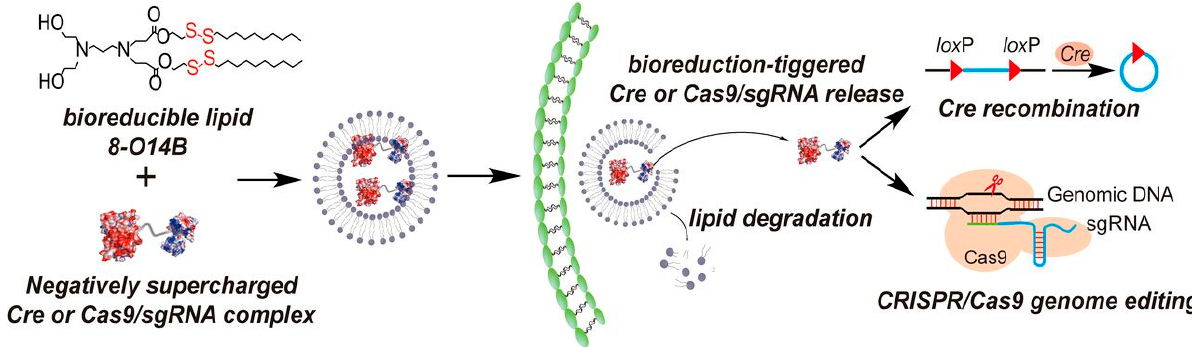
Figure 5. Glutathione-responsive bio-reduceable lipid NP for CRISPR/Cas9 delivery to induce the Cre recombination. Reprinted with permission from ref [48] . Copyright 2016, Proceedings of the National Academy of Sciences.